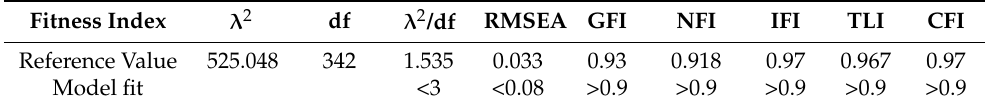
Table 12. Goodness-of-fit test for structural model.